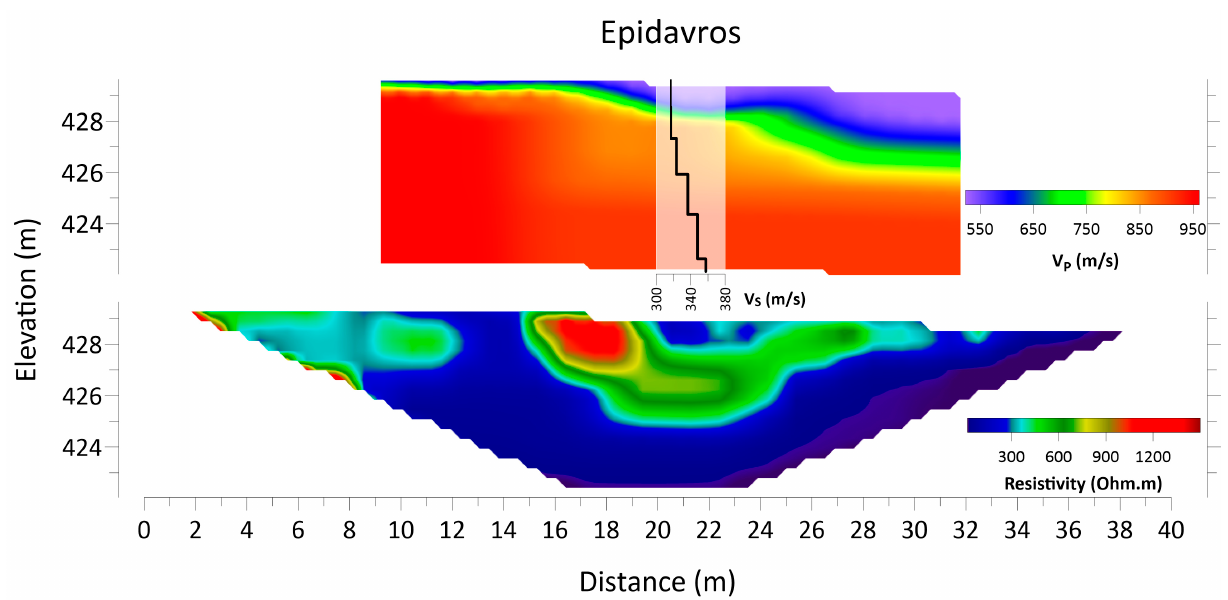
Figure 20. SRT and MASW ( top ) and ERT ( bottom ) sections at site of the seismological station EPID .